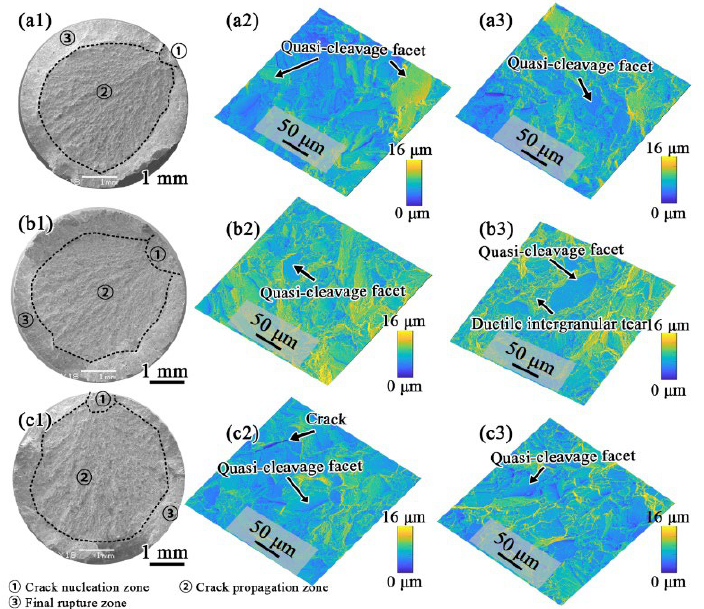
Figure 11. Fractographies of 700 °C tensile specimens of ( a1 ) HT-1, ( b1 ) HT-2 and ( c1 ) HT-3, and height contour coloring maps in middle column of ( a2 ), ( b2 ), ( c2 ) correspond to crack nucleation zones, and these in right column of ( a3 ), ( b3 ), ( c3 ) correspond to propagation zones.